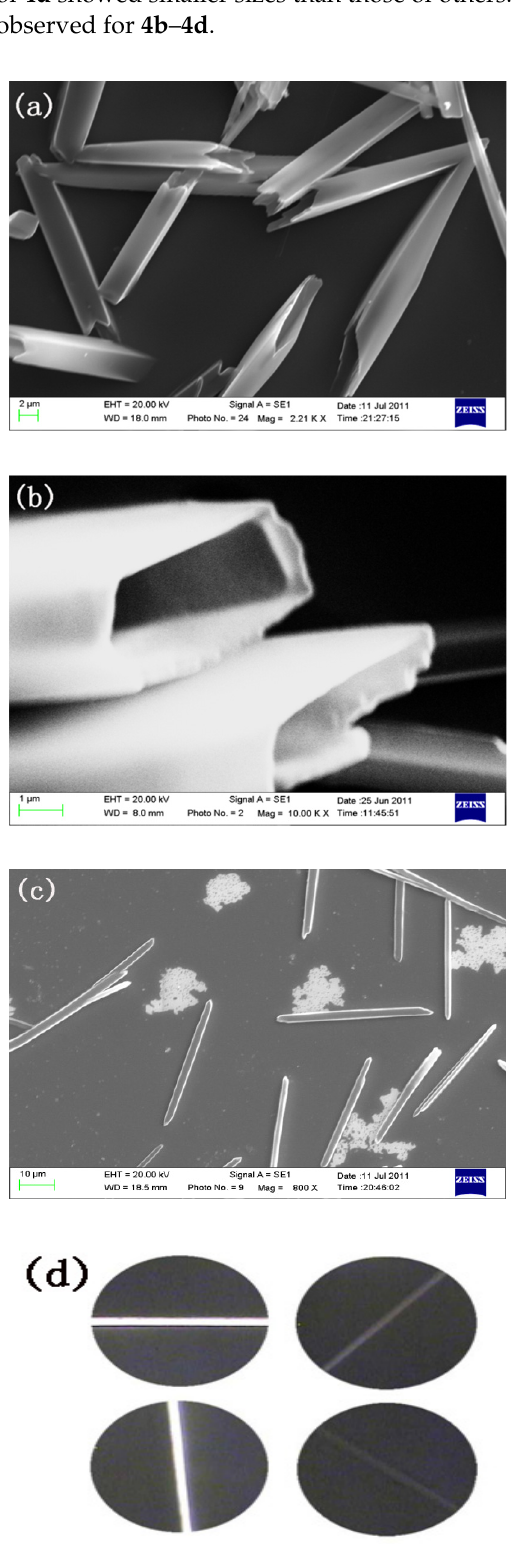
Figure 4. ( a , b ) SEM of micro-square tube by 4a self-assembly; ( c ) SEM of acicular crystal by 4a self-assembly; ( d ) POM of micro-square tube by 4a self-assembly with different angles.